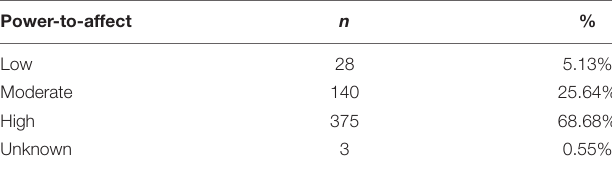
TABLE 4 | The distribution of the variable level of power-to-affect.